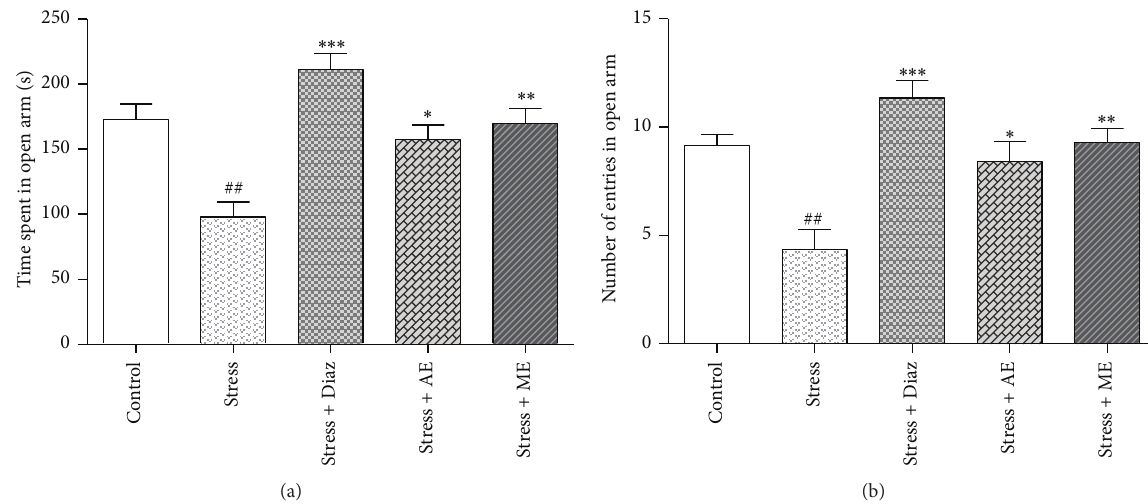
Figure 8: (a) Time spent and (b) number of entries in the open arms in elevated plus maze test. The Diaz, AE, and ME groups were daily treated with the diazepam (2mg/kg, i.p.), aqueous, and methanolic seed extracts of Abelmoschus esculentus (200 mg/kg, p.o.) for 7 days, respectively, once daily and then stress was induced. The values shown are the mean ± S.E.M (𝑛 = 6) ; # 𝑃 < 0.05 , ## 𝑃 < 0.01 when compared to control group, ∗ 𝑃 < 0.05 , ∗∗ 𝑃 < 0.01 , and ∗∗∗ 𝑃 < 0.001 when compared to stress per se group.